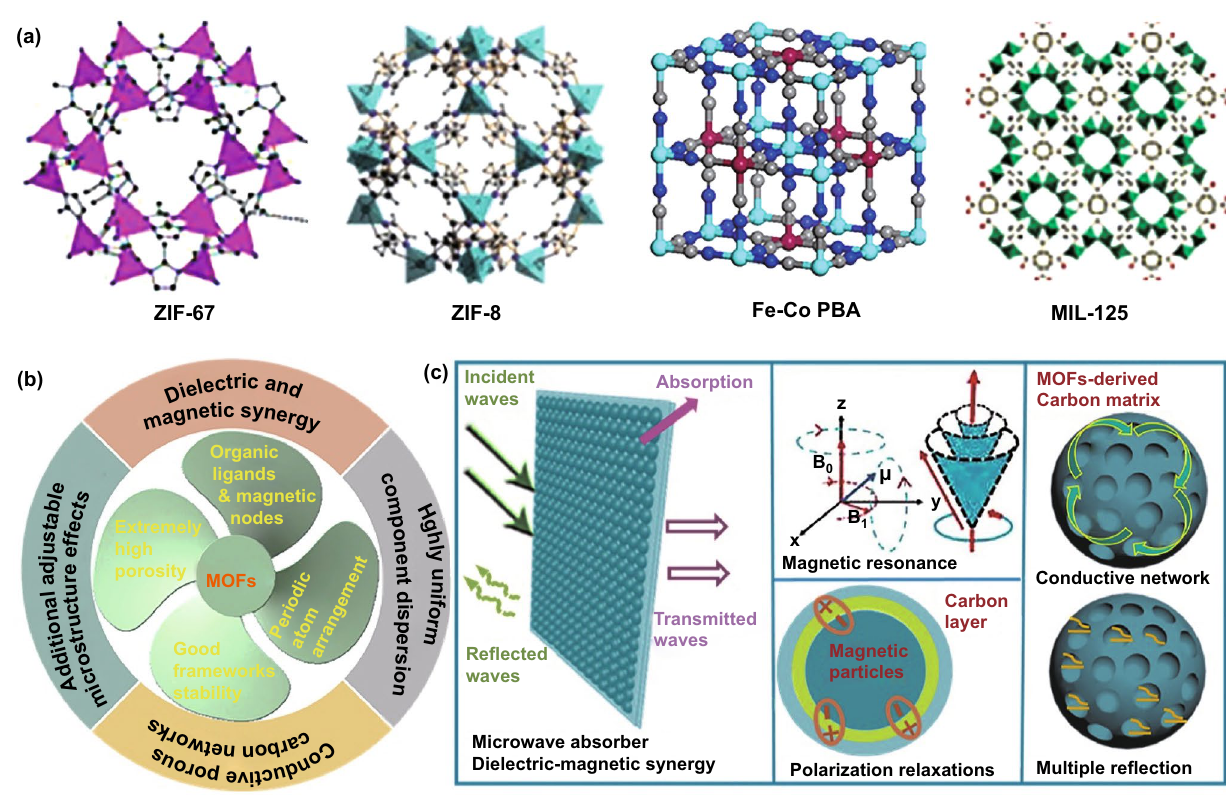
Fig. 1 a Crystalline structures of some specific MOFs. Reproduced with permission from Refs. [24–27]. Copyright © 2017 WILEY–VCH; 2014 The Royal Society of Chemistry; 2018 American Chemical Society; and 2017 Wiley–VCH Verlag GmbH. b Some advantages of MOFs applied in the field of EM absorption, and c Electromagnetic loss and energy conversion mechanism inside MOFs-derived magnetic carbon- based